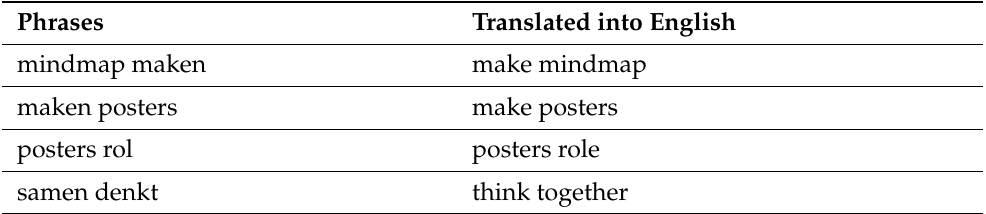
Table 5. Bigrams of the teacher with low tf-idf ranking (i.e., bigrams frequently used).